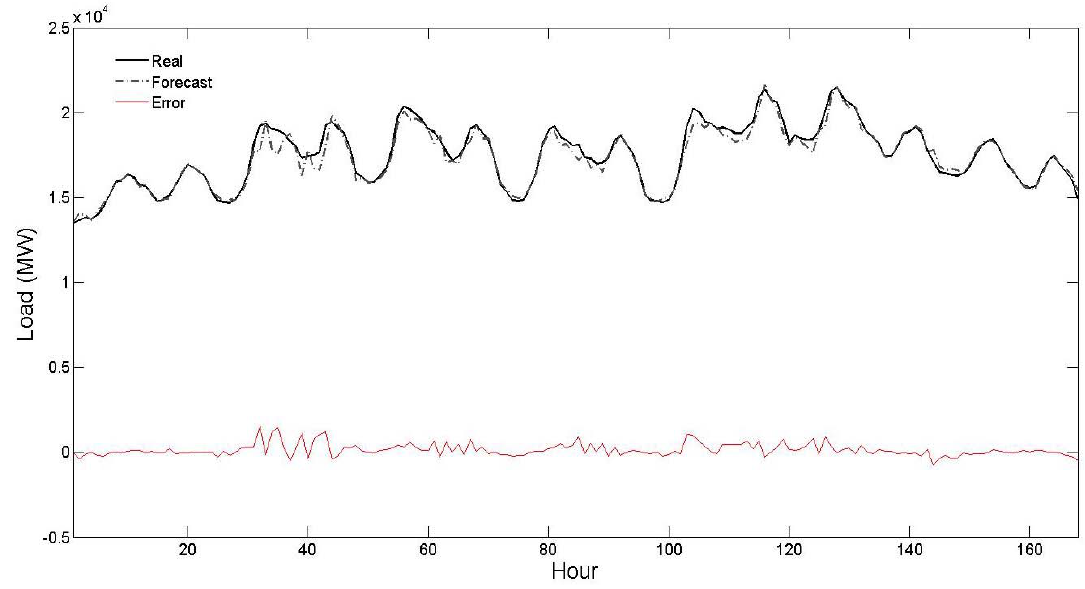
Figure 2. Curves of real values, forecast values and forecast errors for the first test week of Table 1 (the forecast results are related to the proposed strategy).